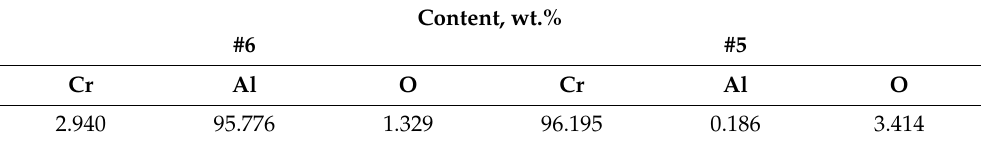
Table 6. Quantitative analysis of composition at the respective points of MeO–Me interfaces. Content, wt.%